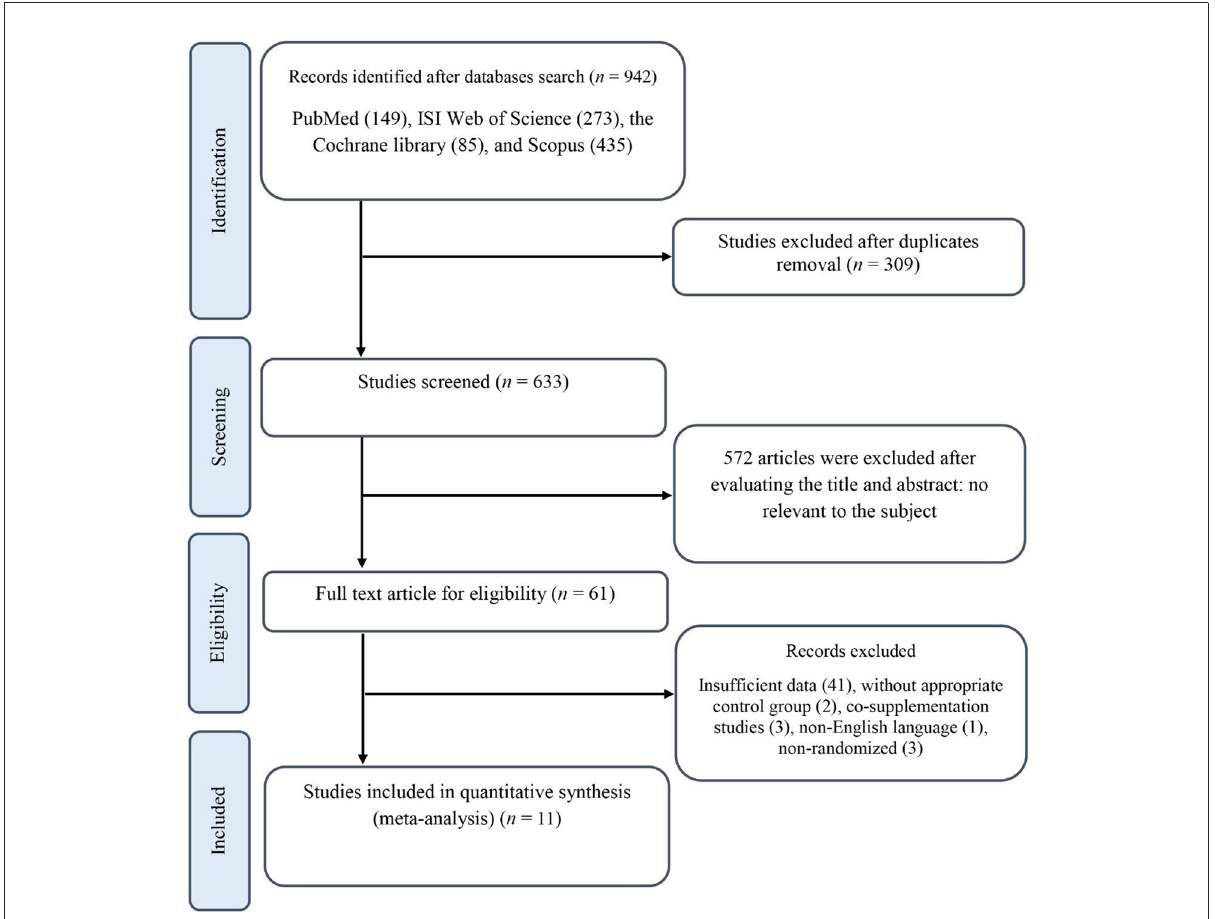
FIGURE1 The preferred reporting items for systematic review and meta-analysis (PRISMA)